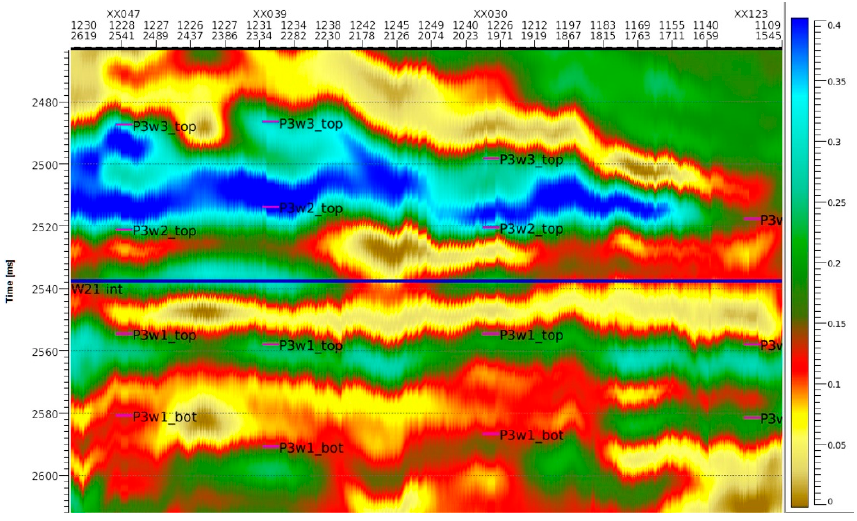
Figure 11. The distribution of clay content after correction.